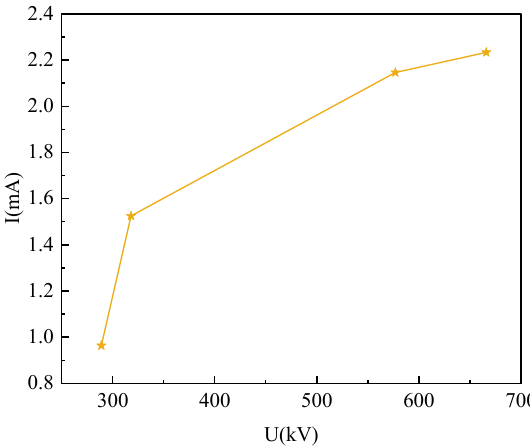
Figure 11. The leakage current changes with the amplitude of the AC voltage.